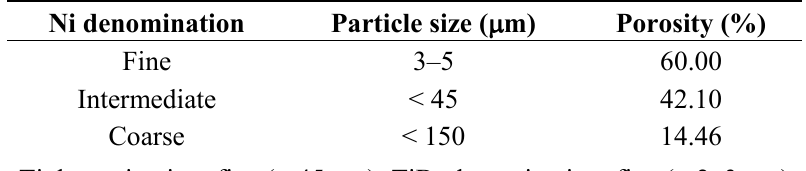
Table 2. Porosity of combustion synthesized samples using different size Ni powder.